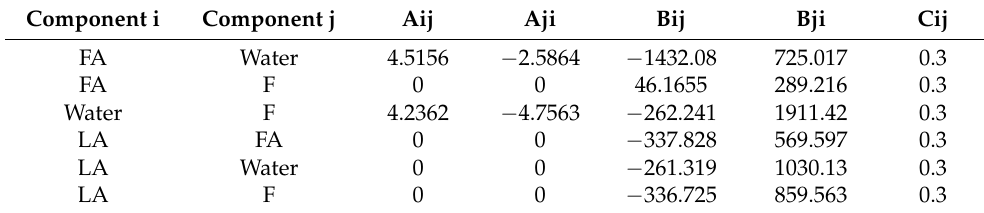
Table 3. Binary interaction parameters (A, B, C) for the feed